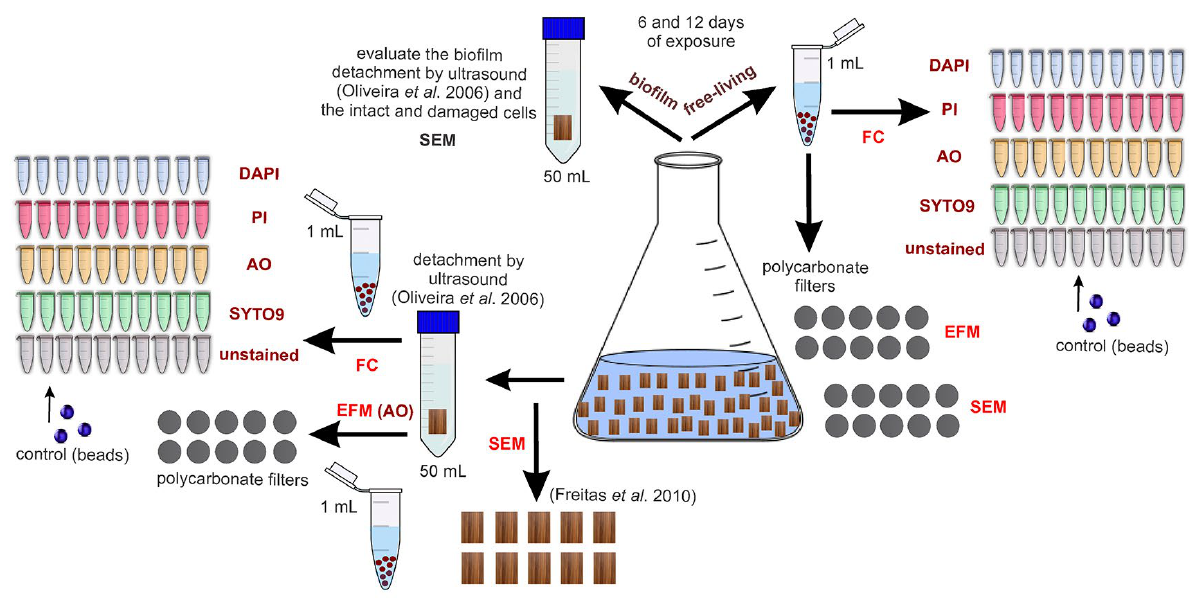
Fig. 1. – Experimental design used to define the best flow cytometer (FC) protocol for counting and measuring planktonic and biofilm marine prokaryotes compared with epifluorescence microscopy (EFM) and scanning electron microscopy